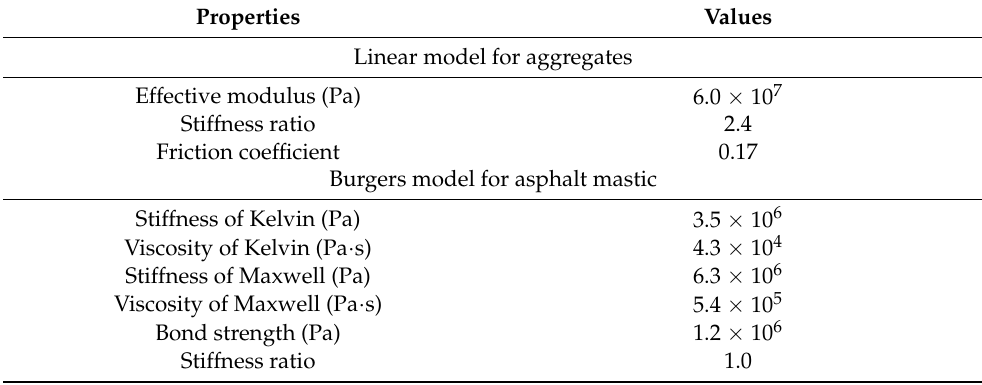
Table 4. Contact models and parameters at 20 ◦